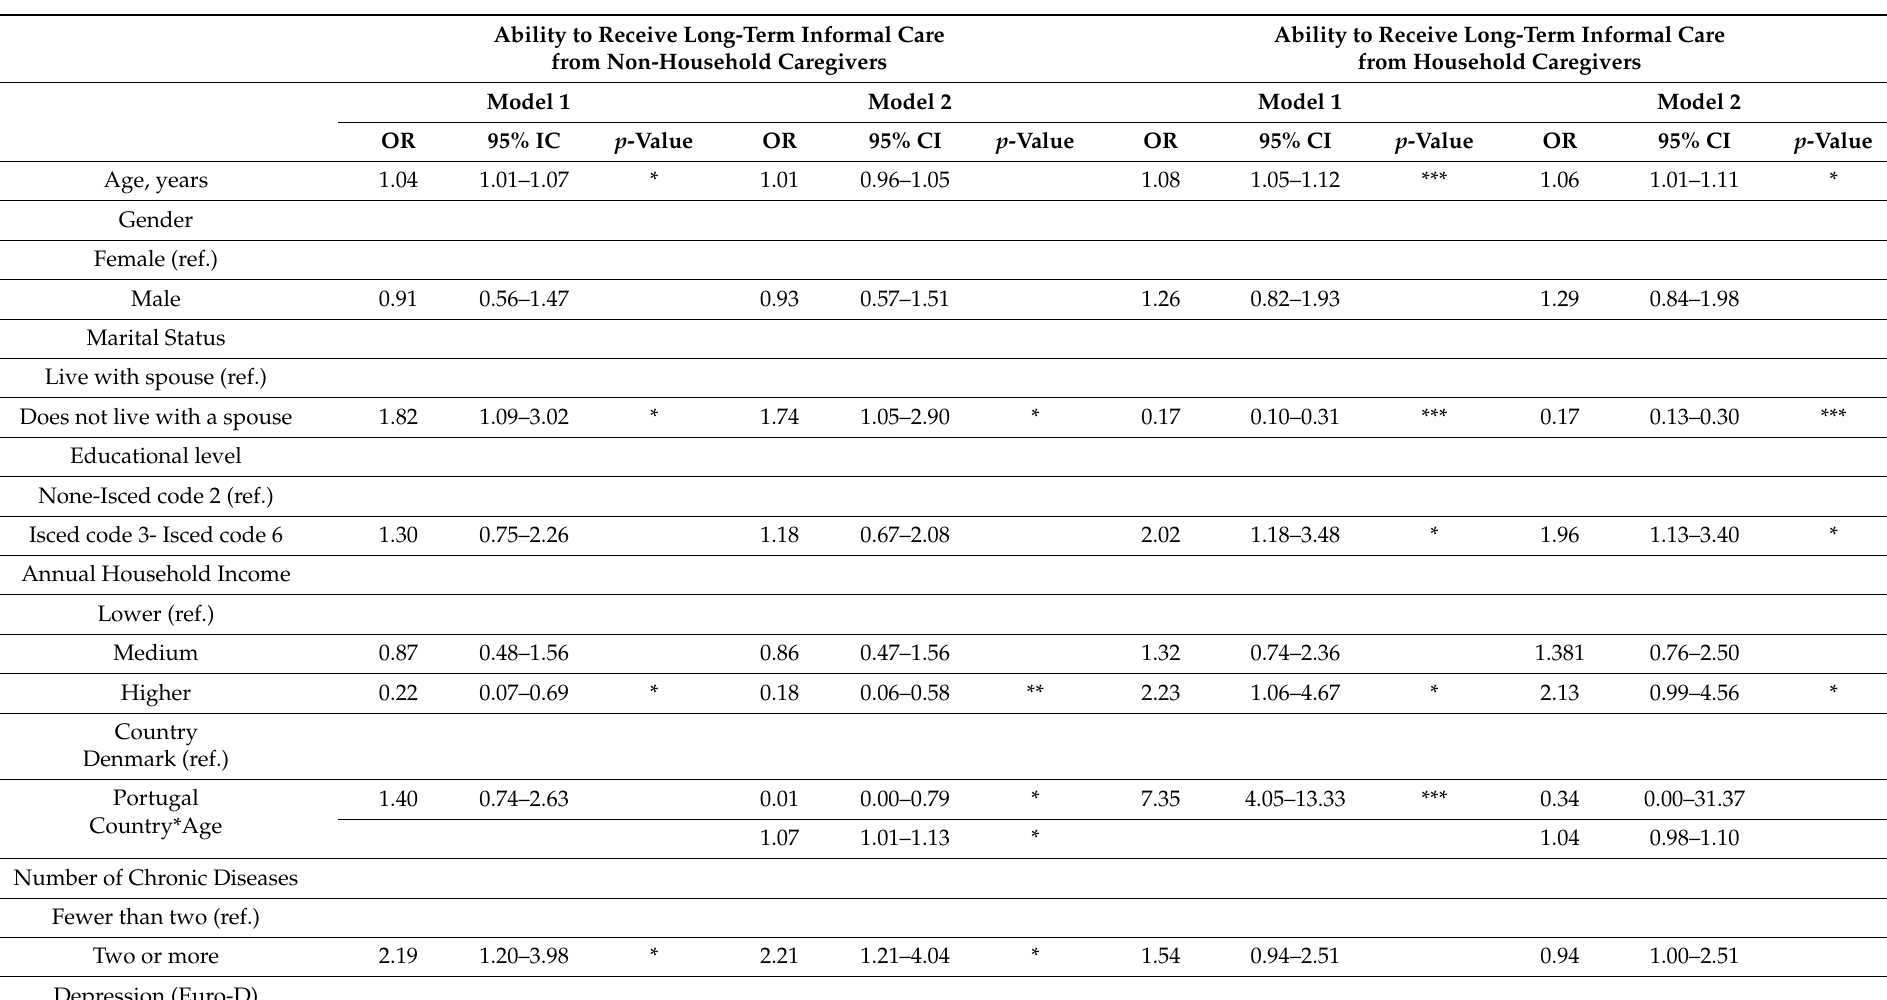
Table 4. Logistic regression models for the ability to receive long-term informal